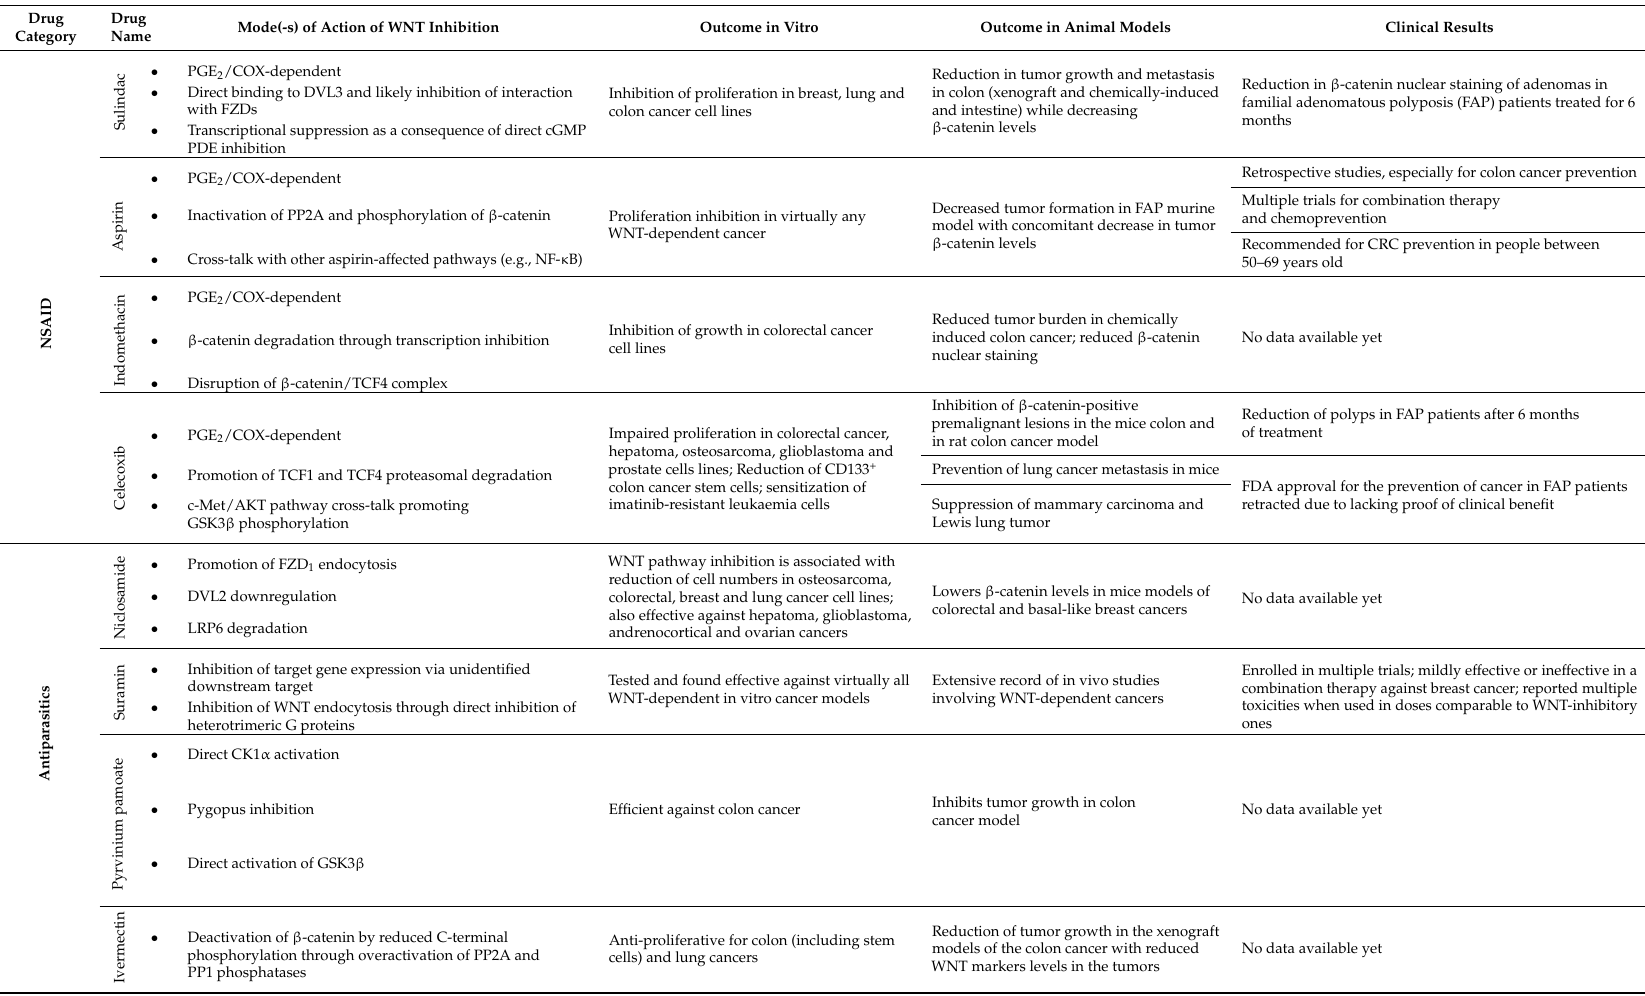
Table 1. List of drugs known to modulate the WNT pathway in